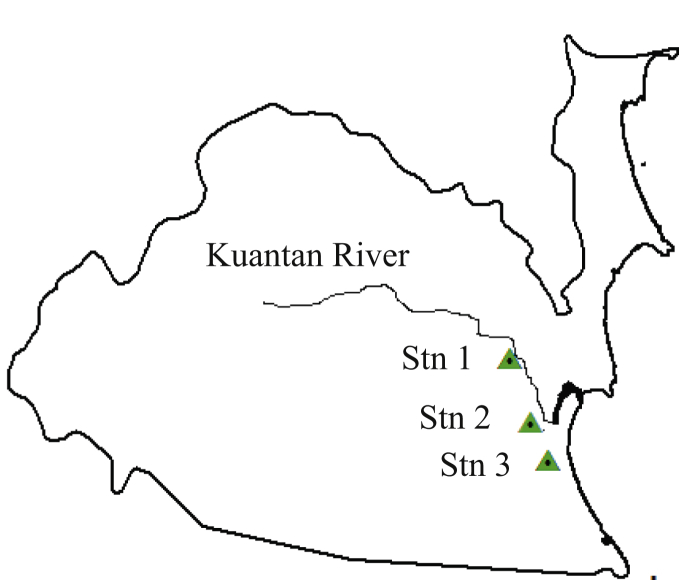
Kuantan river basin.